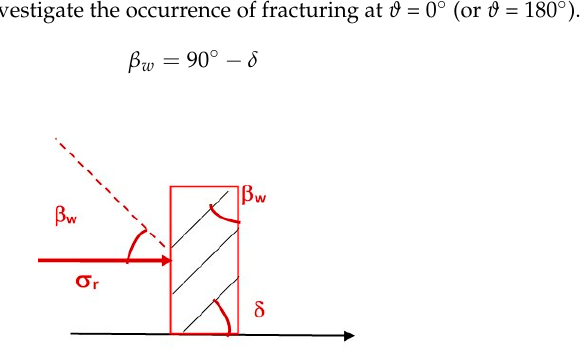
Figure A3. Relationship between δ and β w for the analysis of tensile failure. The dotted red line is the normal to the weakness plane. The radial stress σ r is the maximum principal stress.